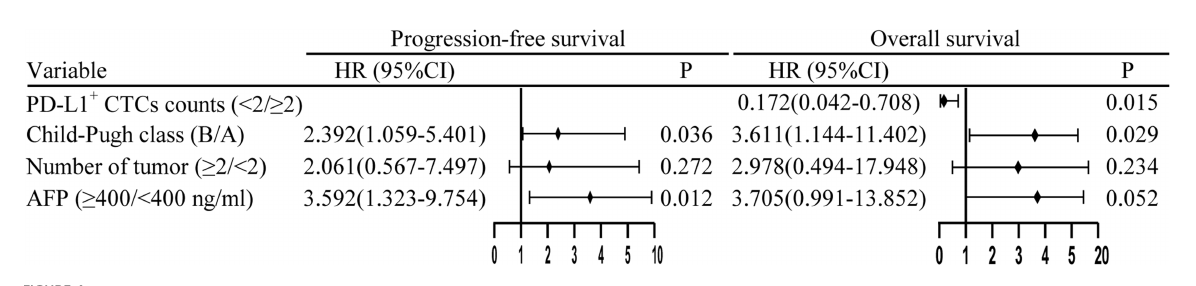
FIGURE 4 Multivariate Cox regression analysis of progression-free survival and overall survival. HR, hazard ratio; CI, con fi dence interval; AFP, alpha fetoprotein; PD-L1, programmed death-ligand 1; CTCs, circulating tumor